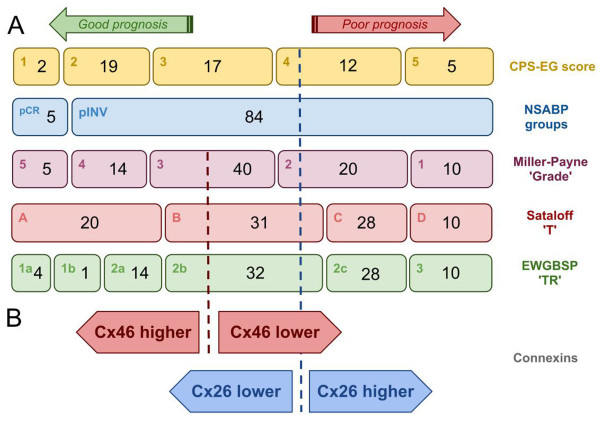
Distribution of the studied patient cohort within current classifications and the power of Cx26 and Cx46 expression to discriminate good and poor prognostic groups within the equivocal categories of NSABP, Miller-Payne G, Sataloff T, EWGBSP TR and MDAAC CPS-EG systems that are used for assessing response to neoadjuvant chemotherapy (A). Both high Cx46 levels and low Cx26 levels correlate with good prognosis (B).